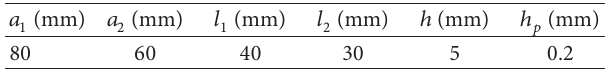
Table 1: Geometrical parameters of unit cell of the